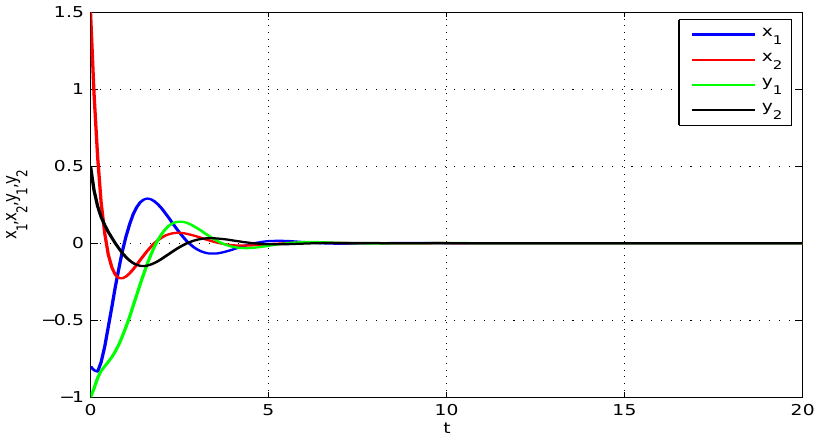
Figure 15. An illustration of the time responses with respect to both the real and imaginary parts of the states p 1 and p 2 pertaining to the model in (13) in a 2 D space, in which ˜ u ( t ) = 0 in Example 4.